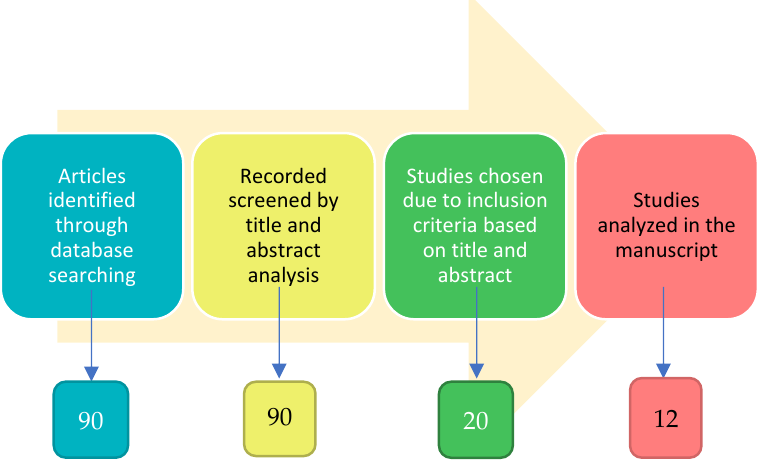
Figure 1. Flow chart of articles selection (see methods).